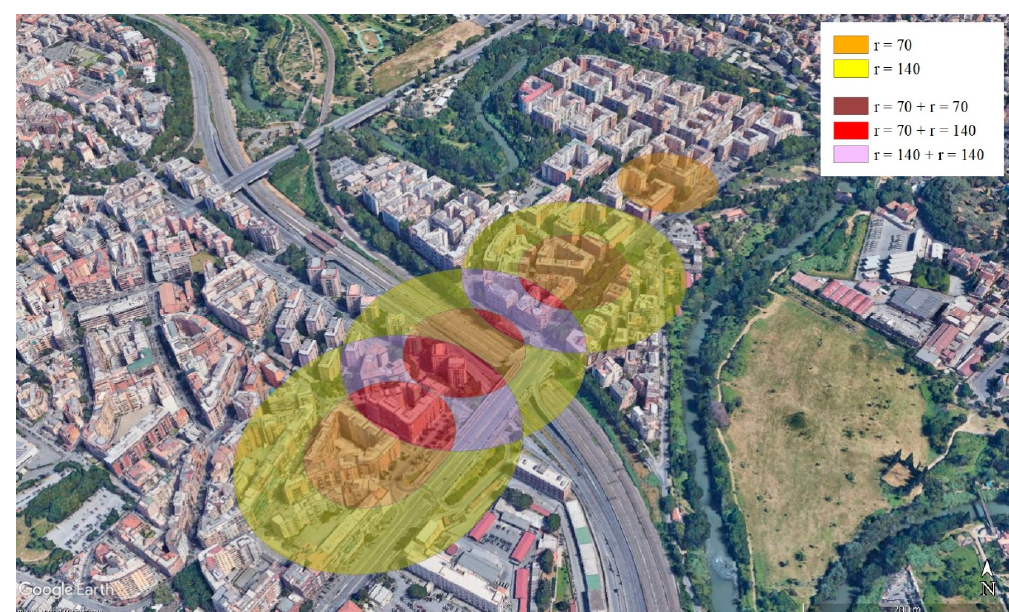
Figure 3. Prime three-dimensional model concerning the circular buffer zones defined by the alignment of RBS (the same as in Figure 1) in a GIS environment. Source: authors’ elaboration.